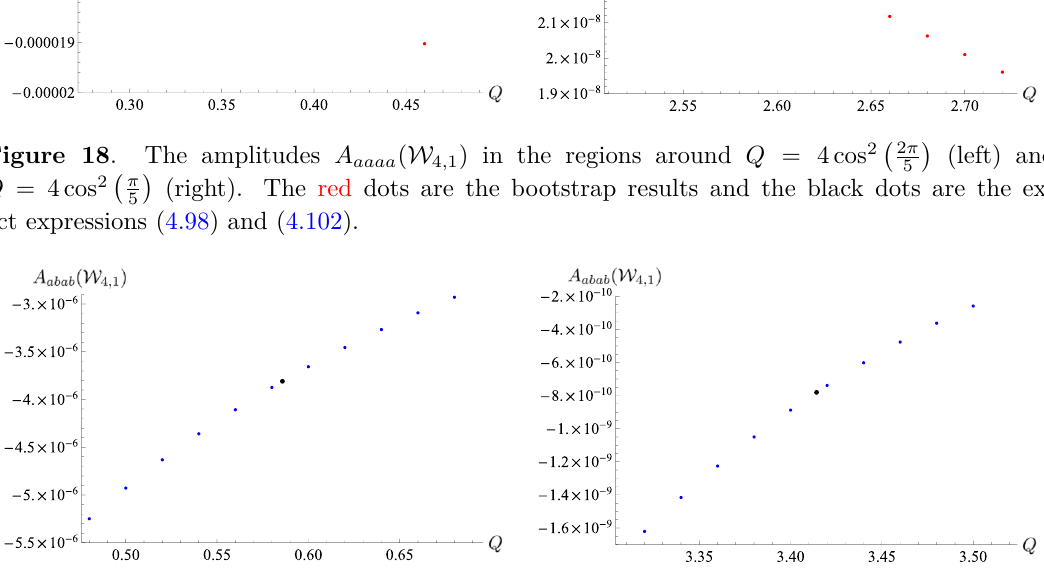
(cid:0) 3 π (cid:1) (left) and 8